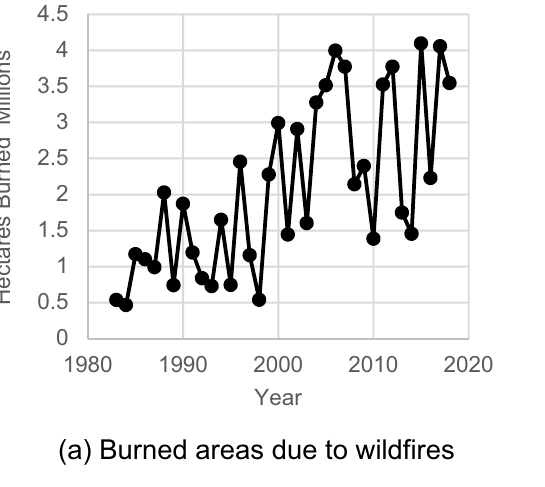
Figure 1. Wildfire in the U.S.1983–2018 (data from www. nifc. gov).